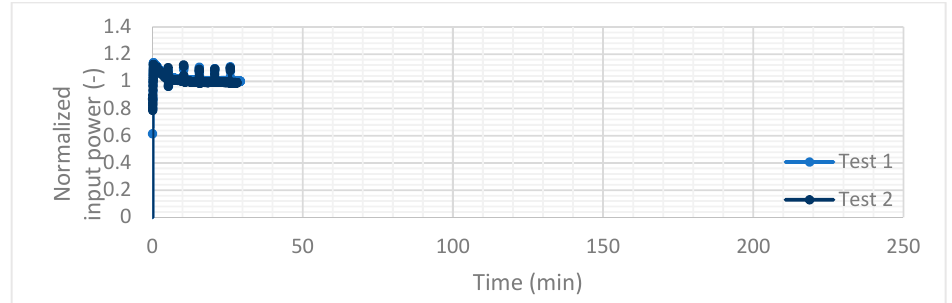
Figure A8. Normalized air volume flow rate trend at a thermostatic temperature of − 30 °C during